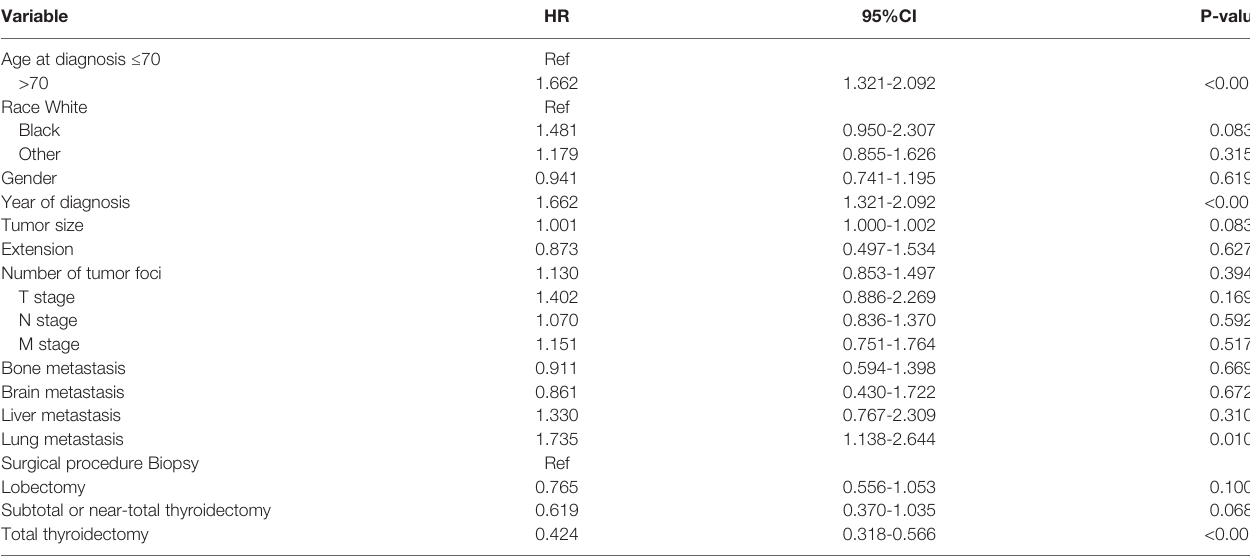
TABLE 3 | Adjusted Cox proportional hazards analyses of cancer-speci fi c mortality for patients with anaplastic thyroid cancer based on the cut-off age at diagnosis of 70 years. Variable